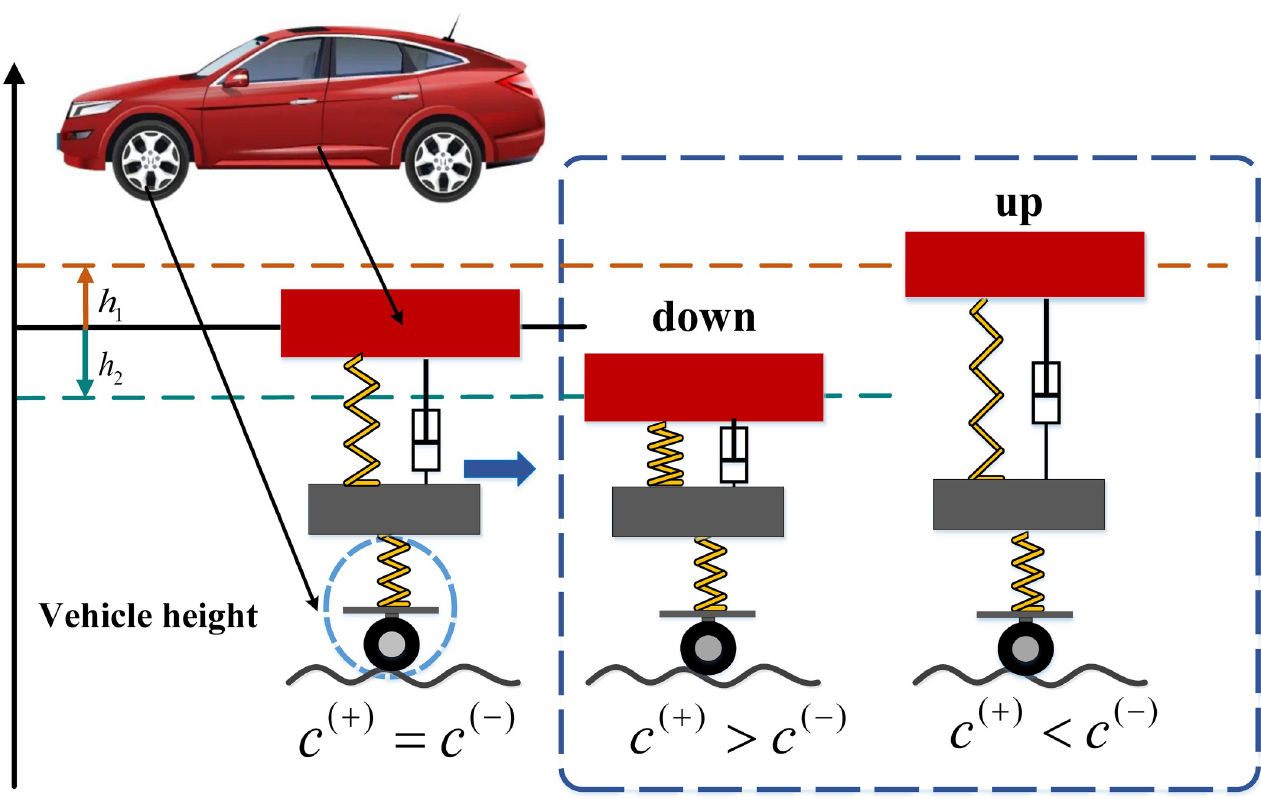
Fig 1. Diagram of the height change in the vehicle body.